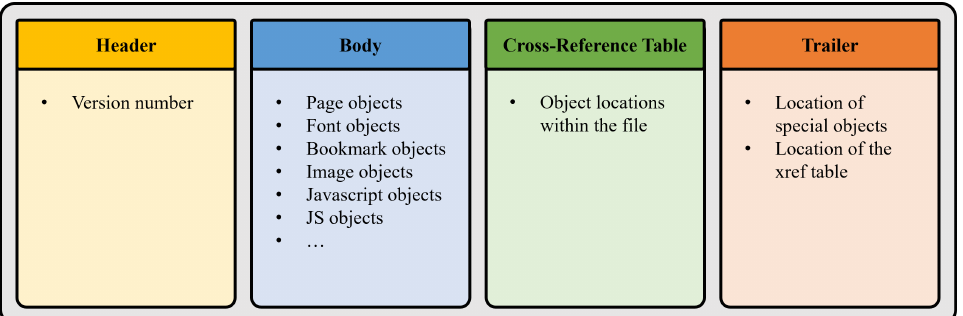
Figure 2. Structure of a PDF